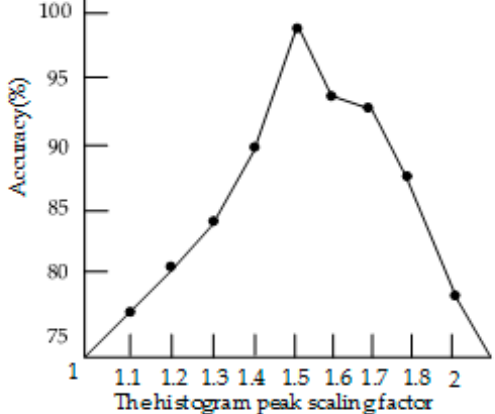
Figure 12. Setting of the scale factor λ .